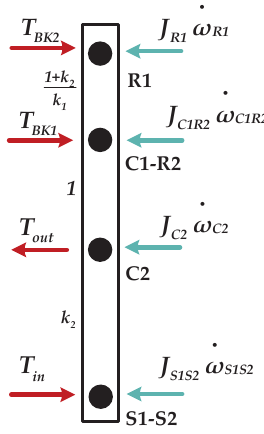
Figure 8. Lever diagram of the two-speed